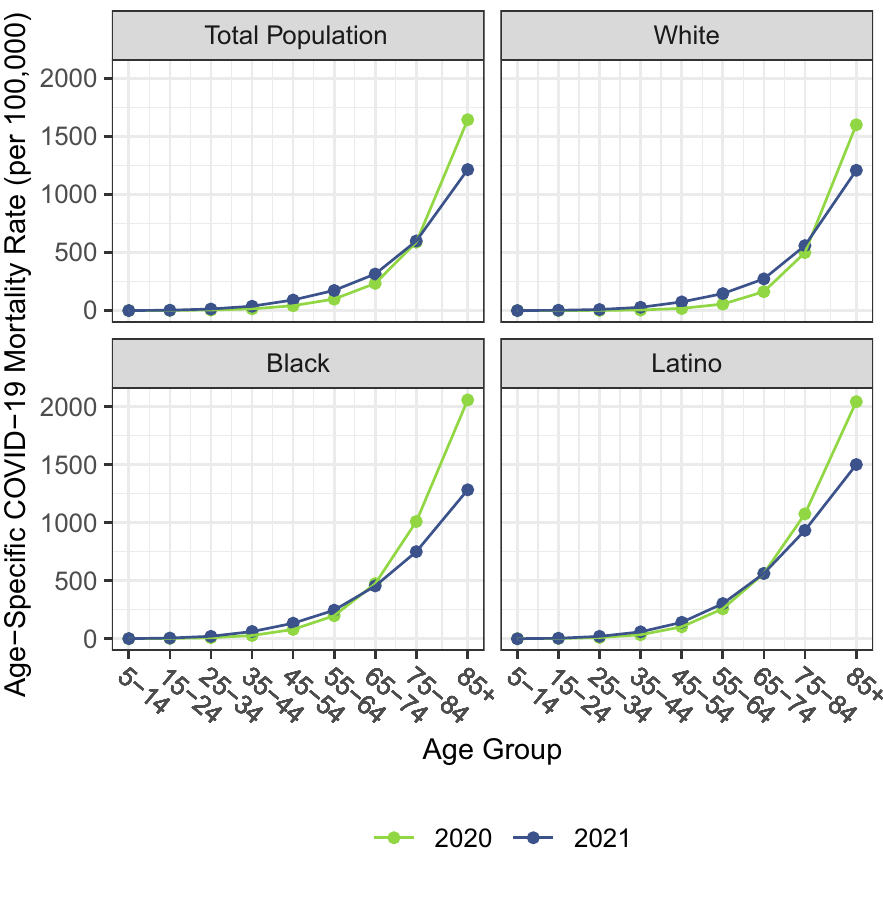
Fig 2. Age-specific COVID-19 mortality rates by race/ethnicity, 2020 and 2021. Data are from CDC WONDER (July 6, 2022, update). Mortality rates below age 5 are not shown because some counts are suppressed.